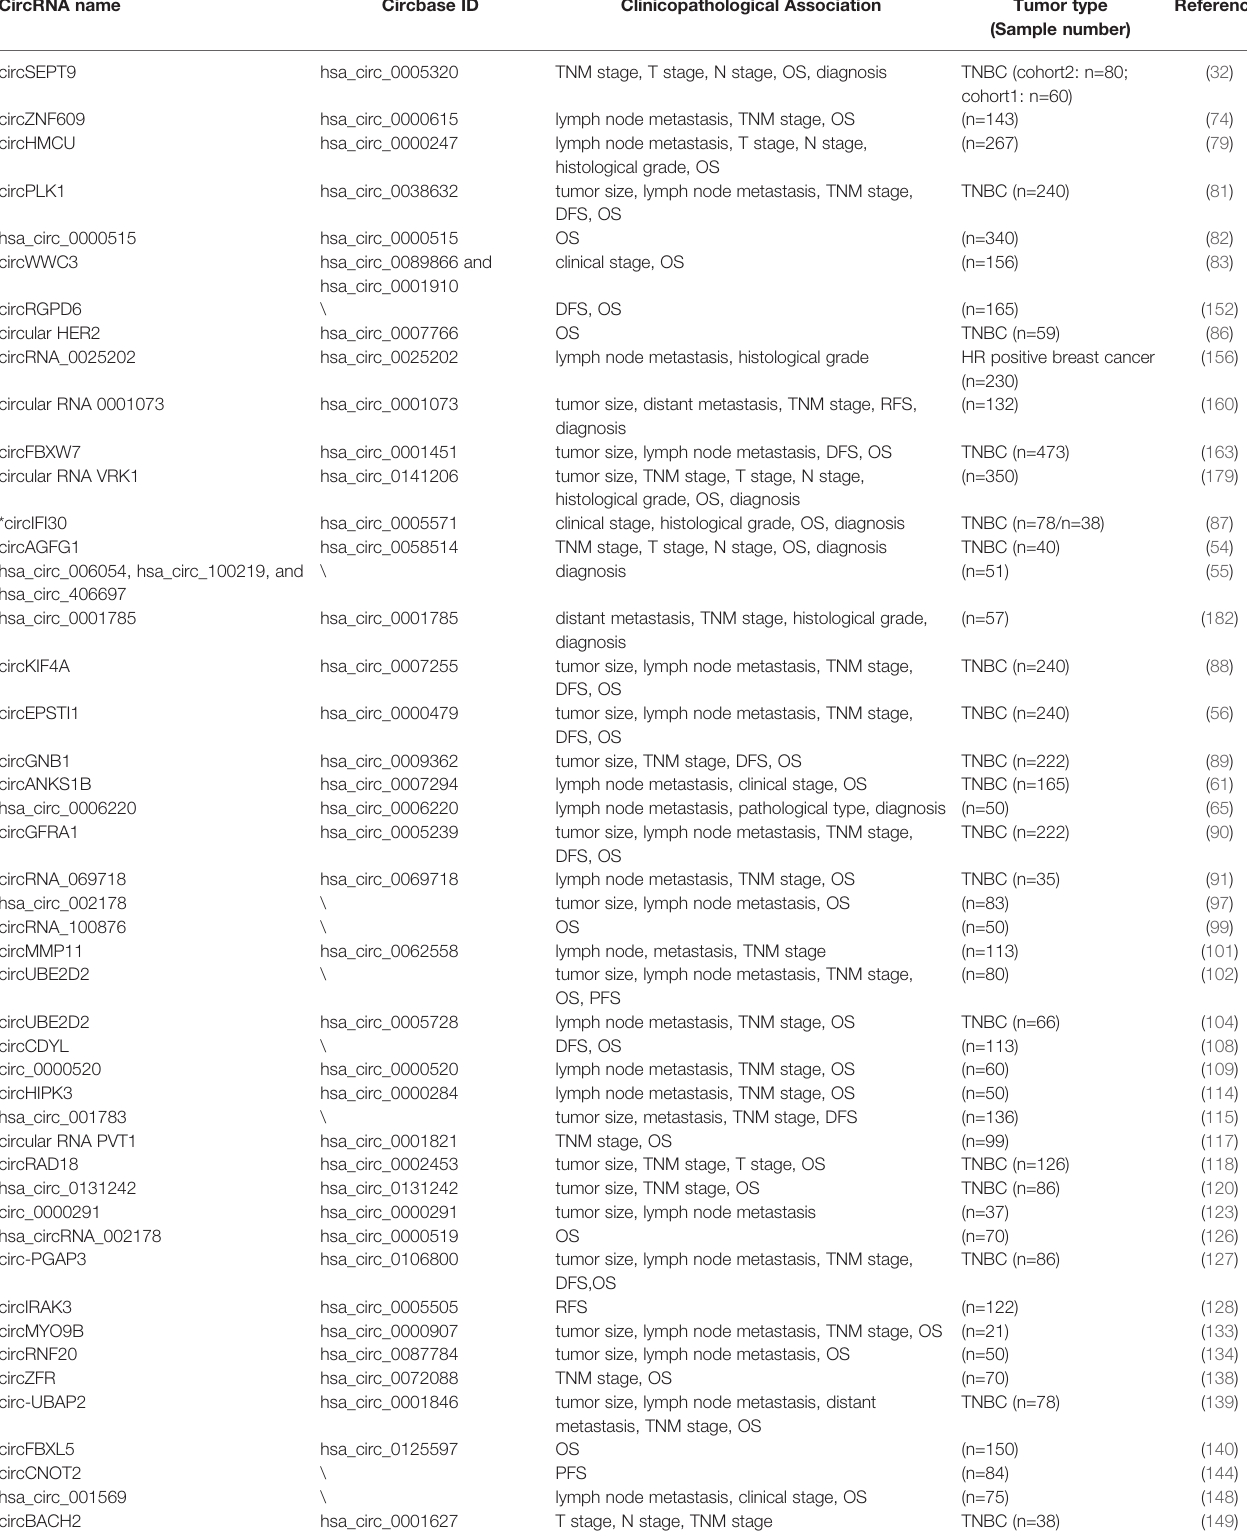
TABLE 4 | CircRNAs with diagnostic and prognostic value in breast